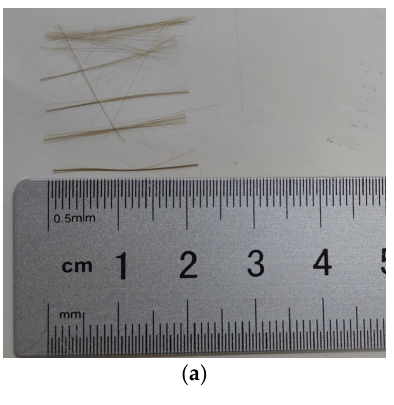
Figure 1. Fiber: ( a ) Basalt fiber ( b ) Steel fiber.